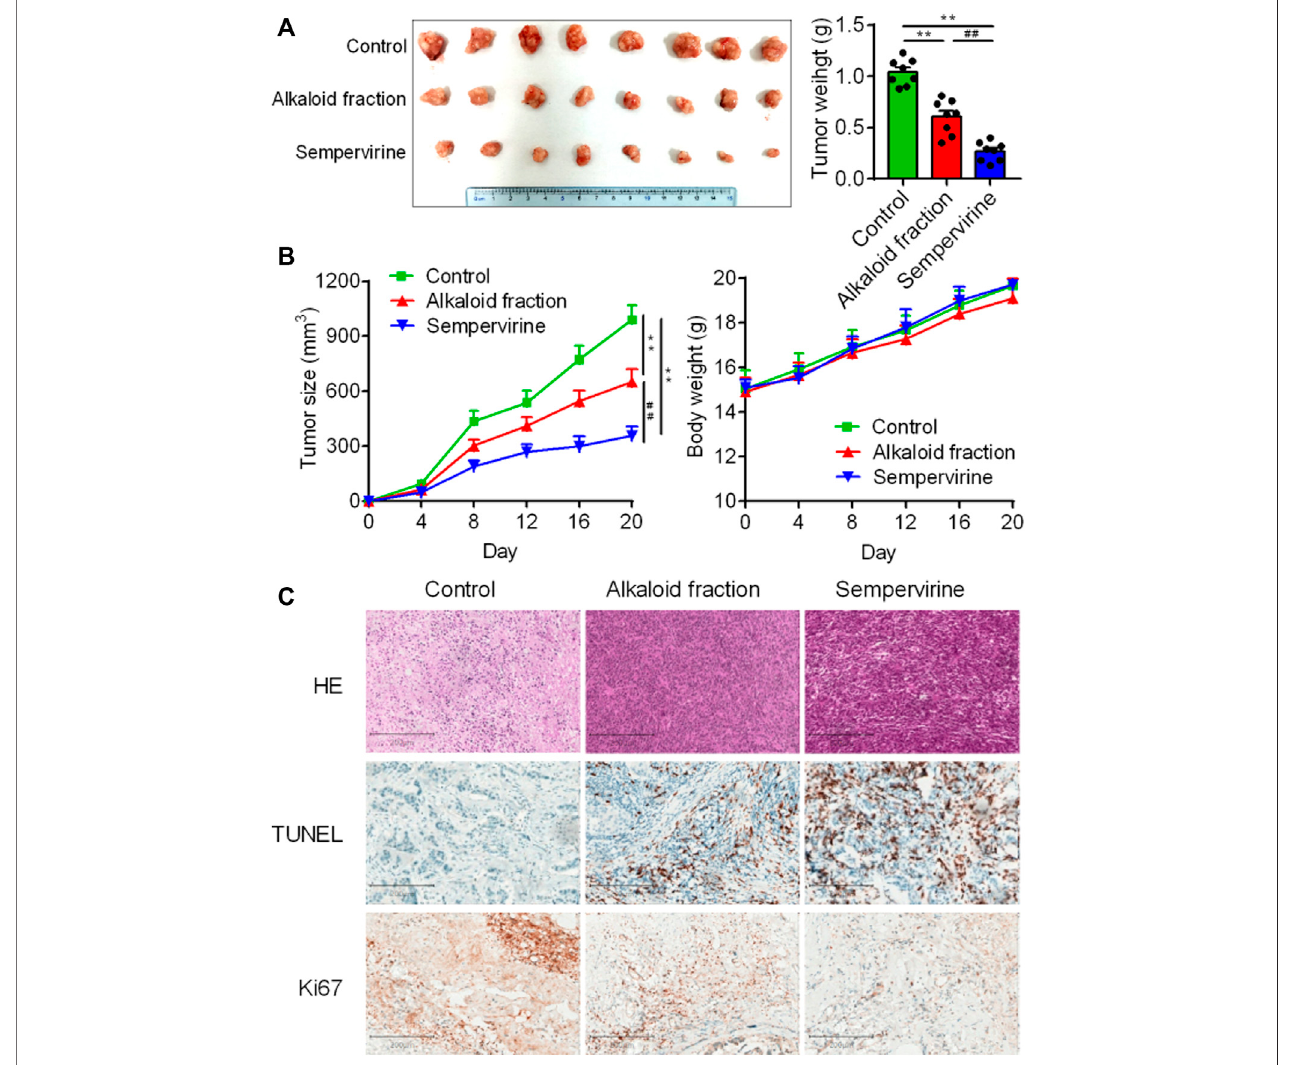
FIGURE 5 | Sempervirine inhibited HCC in vivo . (A) Images of HepG2 subcutaneous inoculation tumors in mice intravenously treated with the sempervirine for 2 weeks. Quanti fi cation of the volumes of tumors was shown. (B) Growth curves of the tumors and quanti fi cation of body weights of the mice during treatment. (C) Representative HE staining, the proliferation marker Ki67 and the apoptosis marker TUNEL of xenografts treated with the sempervirine and the alkaloid fraction. Scale bars (cid:2) 200 μ m. Data are presented as means ± SEM. ** p < 0.01 vs . Control, ## p < 0.01 vs . the alkaloid fraction.